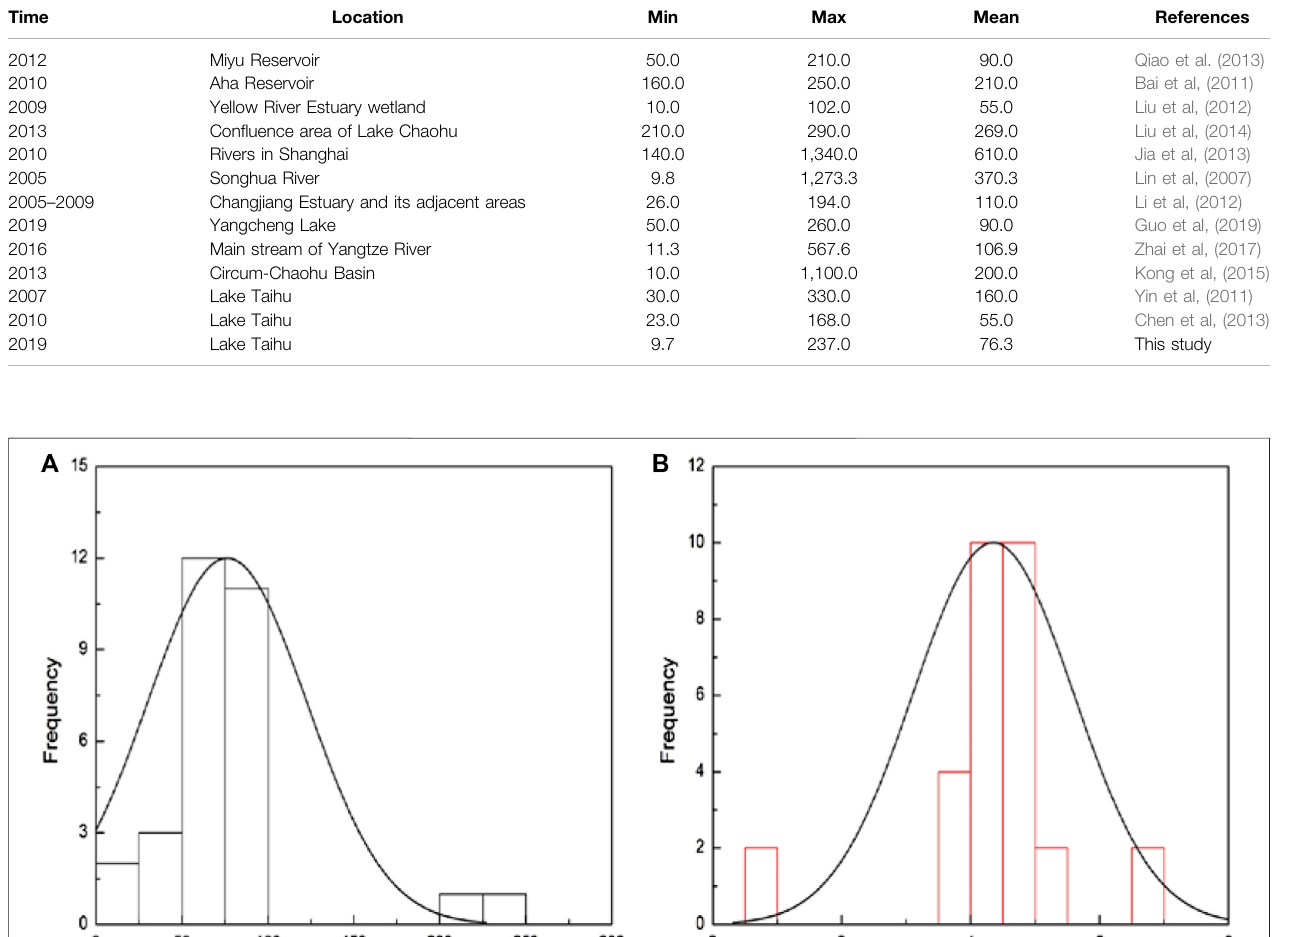
TABLE 1 | Hg concentrations in sediments from several regions in China (ng/g).